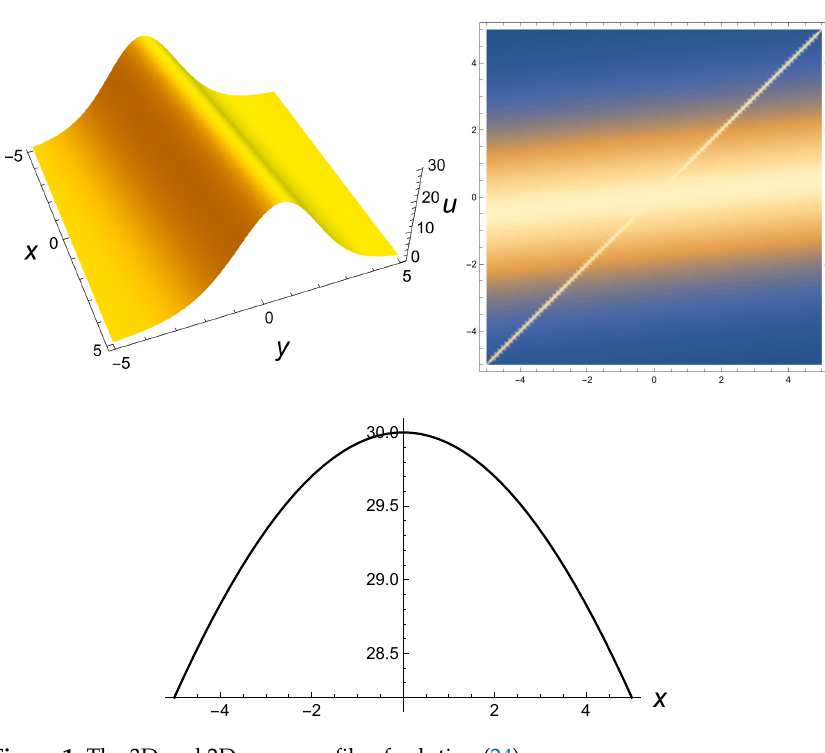
Figure 1. The 3D and 2D wave profile of solution (24).